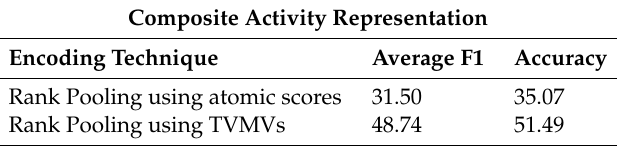
Table 2. Comparison between direct use of atomic scores and their transformation into TVMVs. The evaluation measures are explained in Section